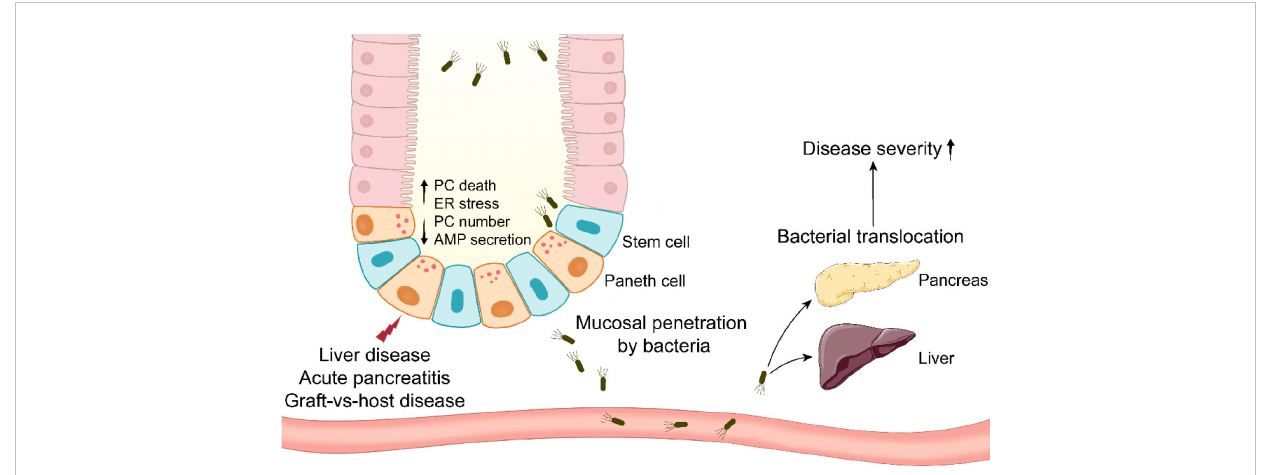
FIGURE 1 Paneth cells in systemic diseases involving bacterial translocation. Paneth cells are impaired in systemic diseases such as liver disease, acute pancreatitis, and graft-vs-host disease. Paneth cell disruption results in mucosal penetration by intestinal bacteria. The bacterial translocation to systemic organs aggravates the disease severity